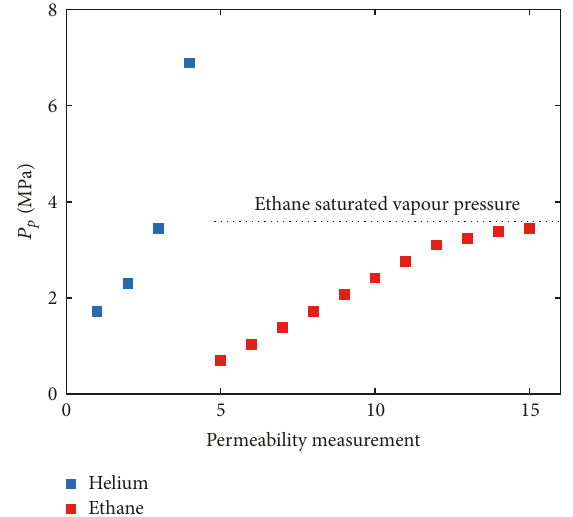
Figure 3: Pore pressure schedule for the suite of helium (blue) and ethane (red) permeability measurements made on each sample. The ethane saturated vapour pressure at the temperature of the permeability measurements (18 ∘ C) is 3.59